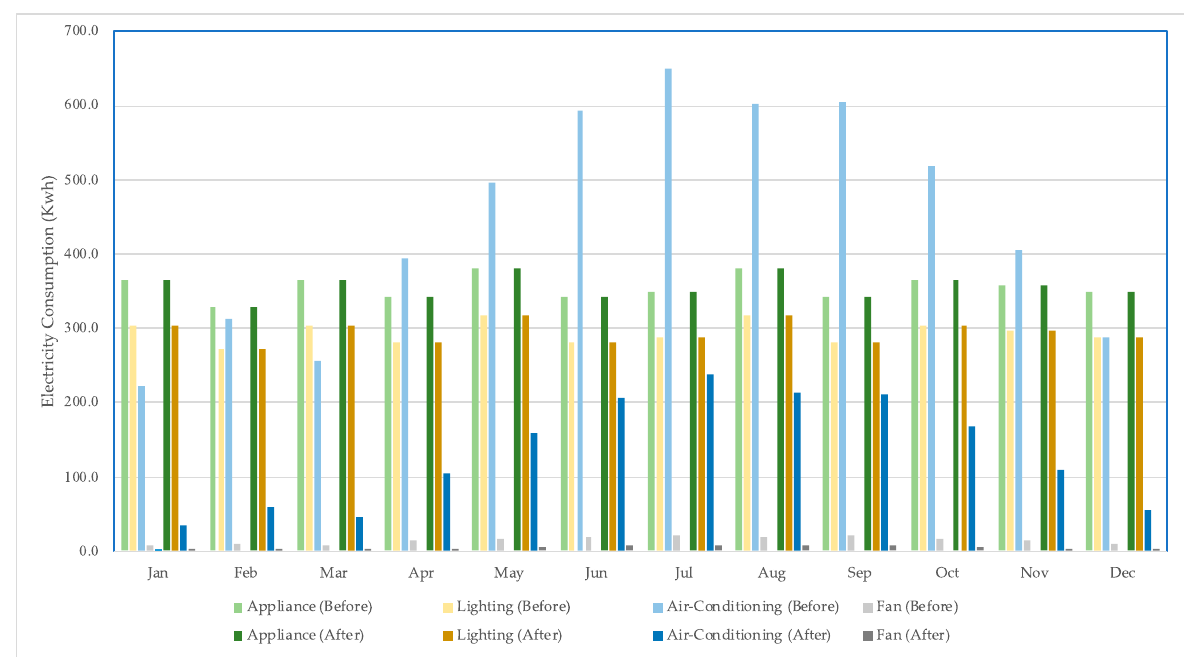
Figure 11. Electricity consumptions for the proposed retrofitting scenario.